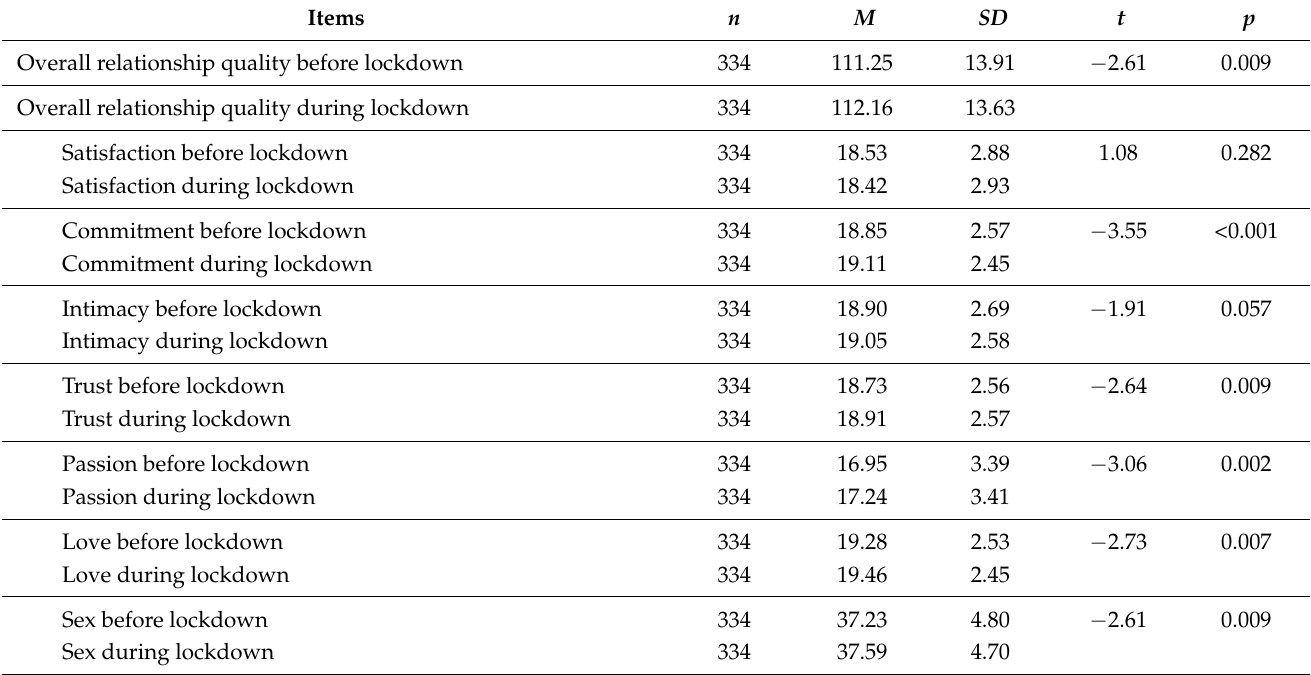
Table 4. Relationship Quality Before and During the COVID-19